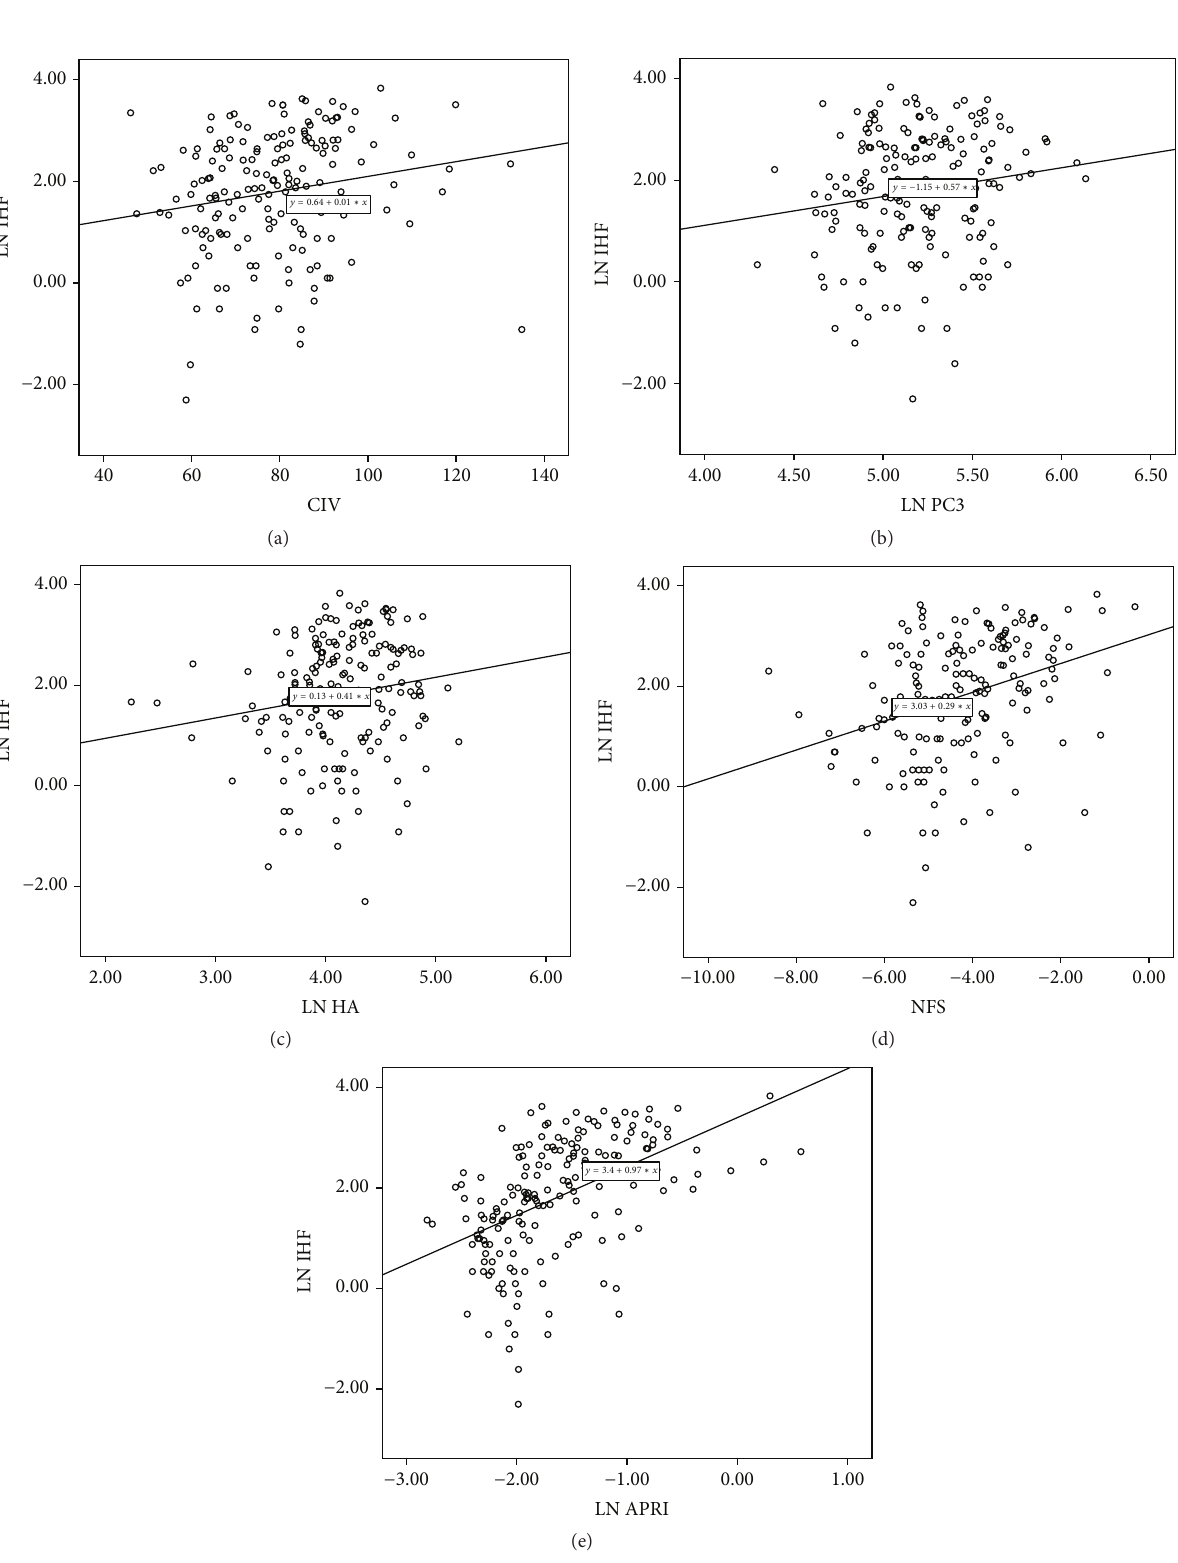
Figure 1: Relationship between IHF and hepatic fibrosis markers. (a) IHF and CIV: 𝑟 = 0.179 , ∗ 𝑃 = 0.017 , (b) IHF and PCIII: 𝑟 = 0.153 , ∗ 𝑃 = 0.041 , (c) IHF and HA: 𝑟 = 0.159 , ∗ 𝑃 = 0.035 , (d) IHF and NFS: 𝑟 = 0.337 , ∗ 𝑃 < 0.001 , and (e) IHF and APRI: 𝑟 = 0.490 , ∗ 𝑃 < 0.001 . ∗ means 𝑃 < 0.05 , the relationship is